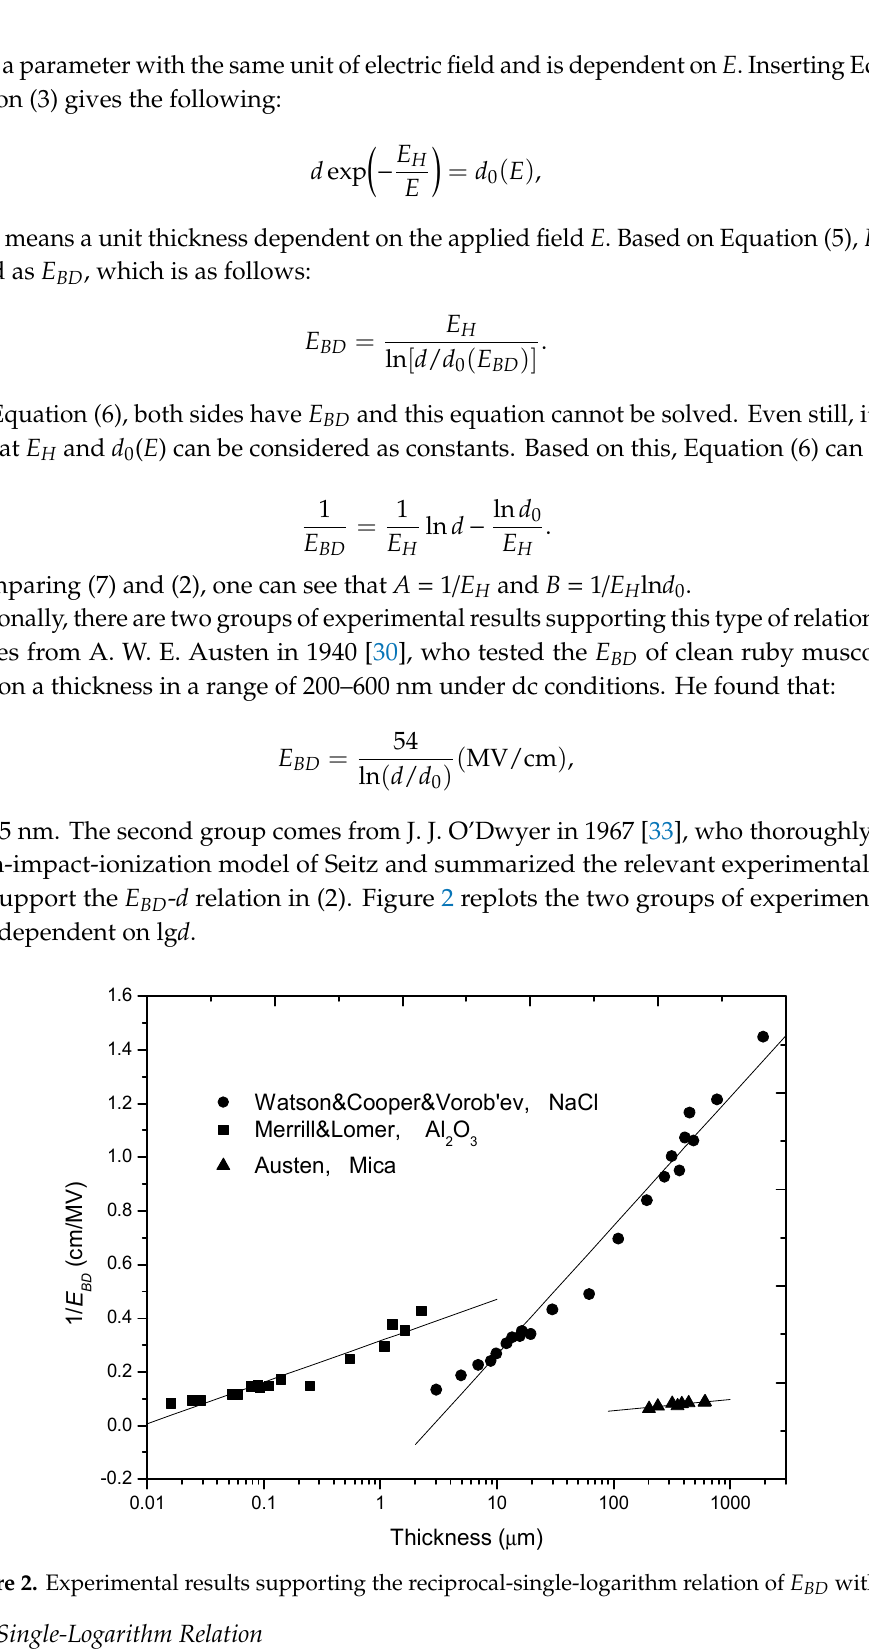
Figure 2. Experimental results supporting the reciprocal-single-logarithm relation of E